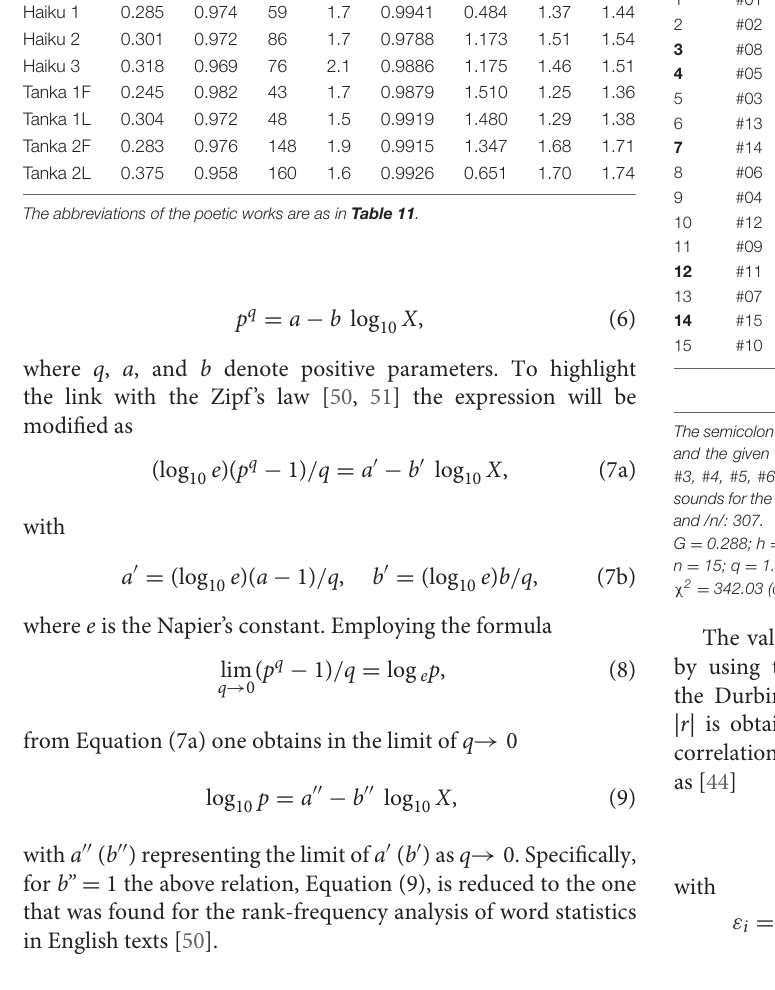
TABLE 12 | List of the Gini coefficient G , the relative entropy h , the number of regression points, n , the optimal exponent of rank-ordered frequency, q , the degree of fit, | r |, the Durbin-Watson ratio d , the lower critical value of the ratio, d L (the 1% point), and its upper counterpart d U . G